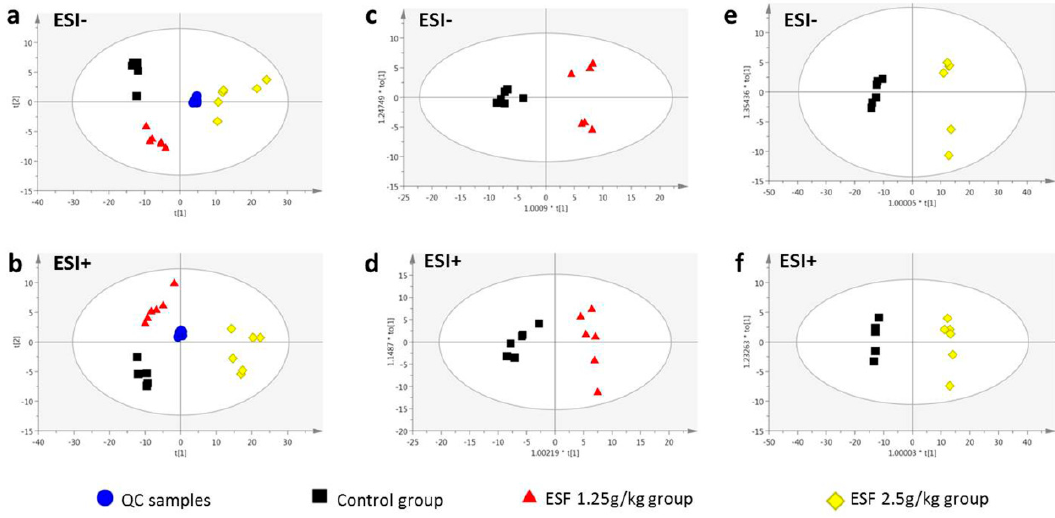
Figure 4. Scores plots of principal components analysis ( a , b ) and orthogonal partial least squares discriminant analysis ( c – f ) models based on the data of serum samples of rats dosed with extract of Sophora flavescens for two weeks from UPLC/MS profiling data with the statistical parameters as follows: ( a ) R 2 X = 0.969, Q 2 = 0.918; ( b ) R 2 X = 0.875, Q 2 = 0.775; ( c ) R 2 X = 0.781, R 2 Y = 0.962, Q 2 = 0.906;